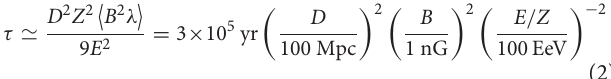
the relation between the two, we show for illustration dashed diagonal lines for the condition L CR